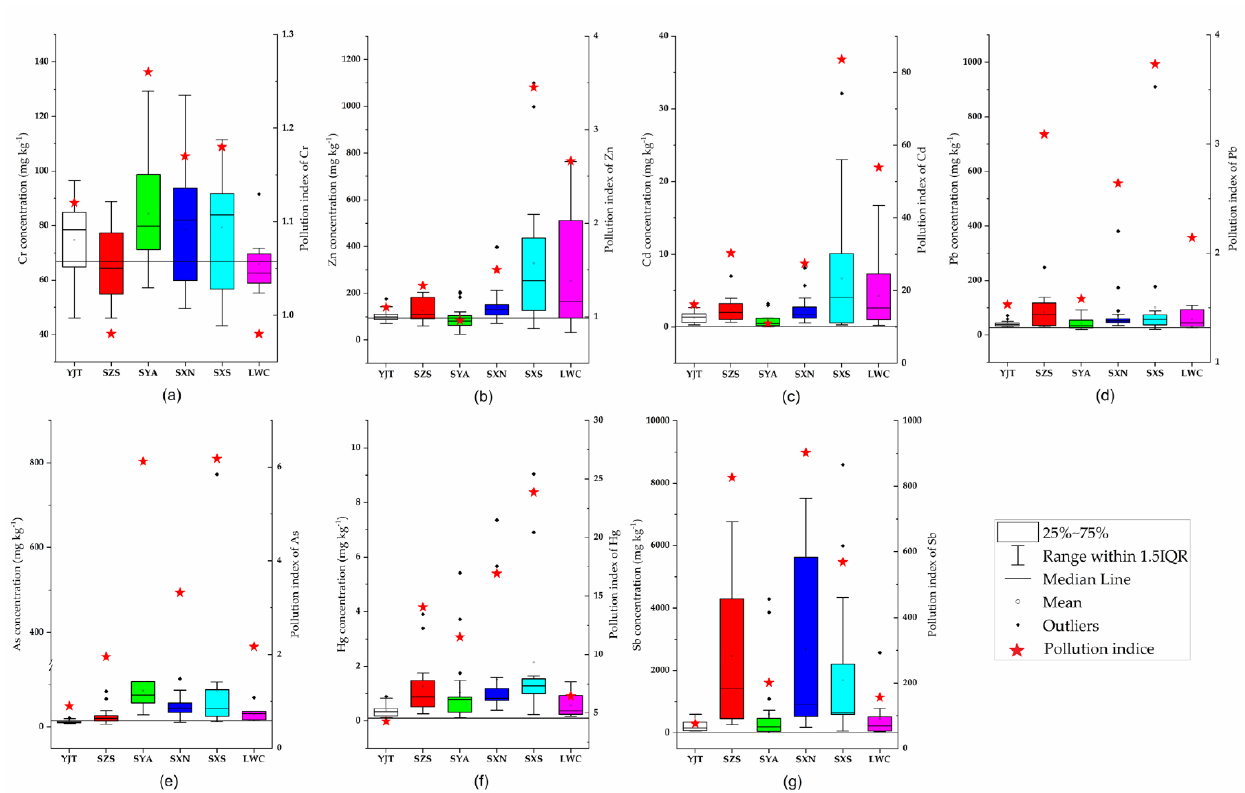
Figure 2. Boxplots of the PTEs concentrations (mg kg − 1 ) in the soils from the six sampling sites YJT ( n = 18), SZS ( n = 14), SYA ( n = 19), SYN ( n = 24), SYS ( n = 20), and LWC ( n = 11). ( a ) Cr, ( b ) Zn, ( c ) Cd, ( d ) Pb, ( e ) As, ( f ) Hg, and ( g ) Sb. The boxes span from the 25th percentile to the 75th percentile. The circle inside each box represents the mean. The whiskers of each box denote the interval between the minimum and maximum values. The black dots outside each box represent the outliers. The red star represents the average of pollution indices of each element. The black lines (BVSH) represent the background value for soils in Hunan (Table S1).